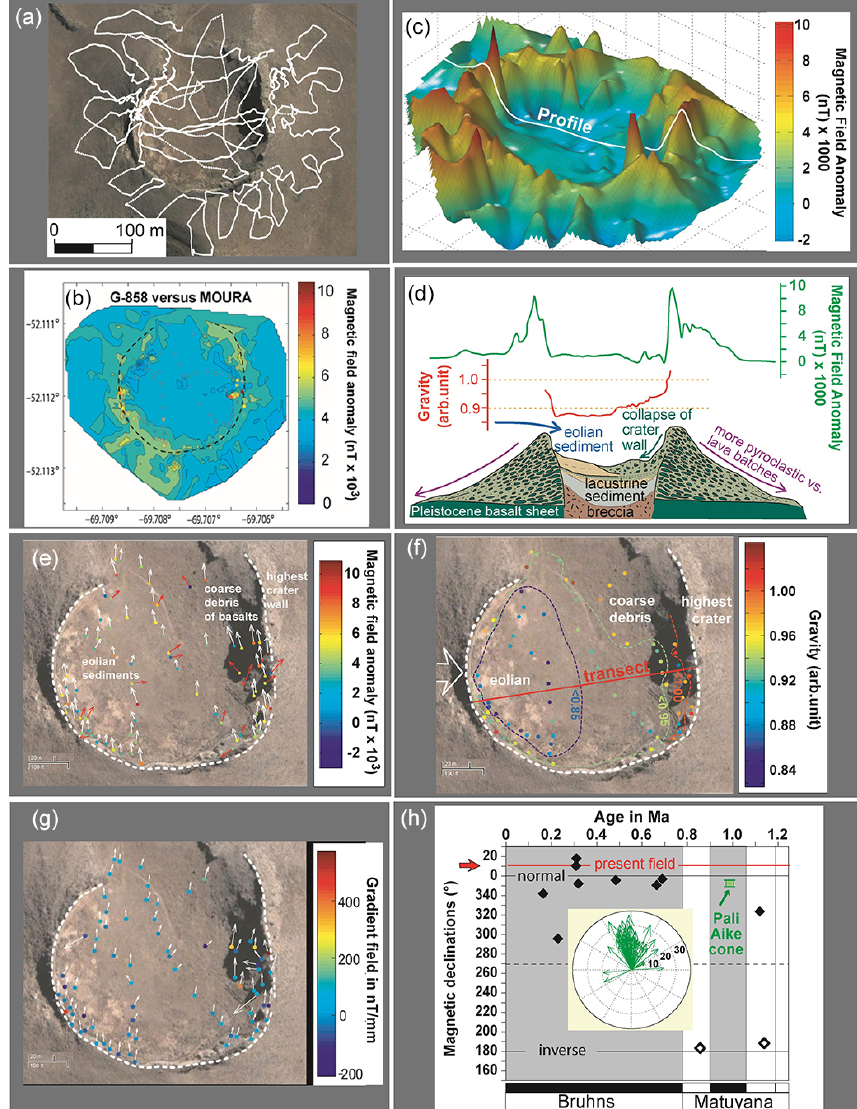
Figure 3. Magnetic and geological aspects of a Pali Aike crater and its surroundings. (a) Survey grid with G-858. (b) Comparison of the interpolated magnetic anomaly map of G-858 and discrete measurements of the MOURA shown in a comparable colour code. (c) 3-D view of interpolated magnetic anomalies with the position of the transect shown in (d) . (d) East–west transect across the crater and its geological structure. Magnetic field anomalies are indicated in green and gravity values in red. (e) Magnetic anomalies of the MOURA and its declination. Red arrows indicate declinations of removed blocks and white arrows that of consolidated rocks. (f) Gravity measurement points in the crater. A white arrow indicates the direction of typical westerly wind and related eolian deposits in the crater. (g) B zx , B zy , and B zz components of the gradient field in nTmm − 1 . (h) Quaternary palaeomagnetic anomalies. Single diamond data points indicate ages and palaeo-orientations of different old volcanic rocks of Pali Aike determined by Mejia et al. (2004) and a rosette indicates declinations measured with the